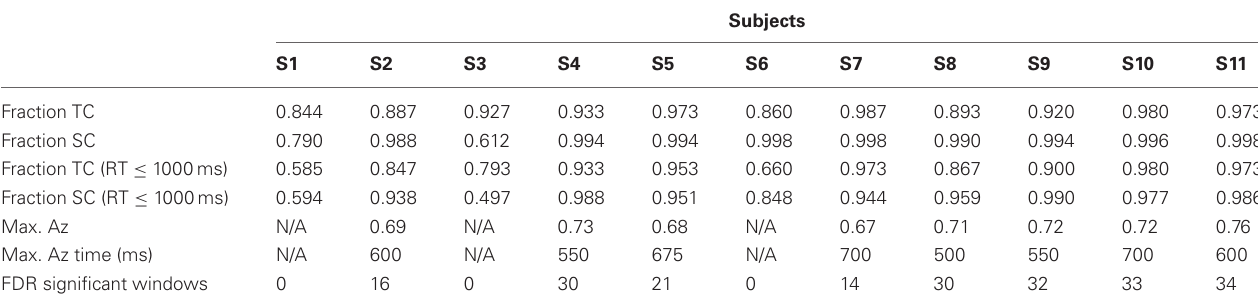
Table 1 | Behavioral results and stimulus-locked discrimination summary.